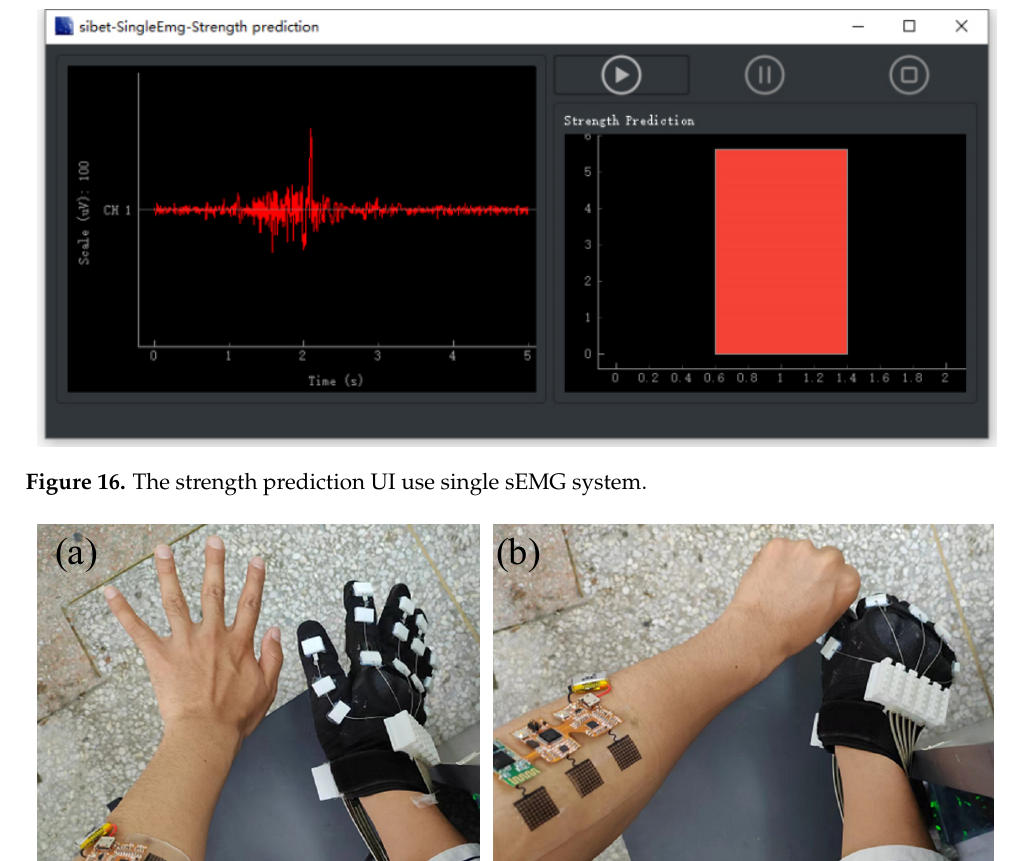
Figure 16. The strength prediction UI use single sEMG system.